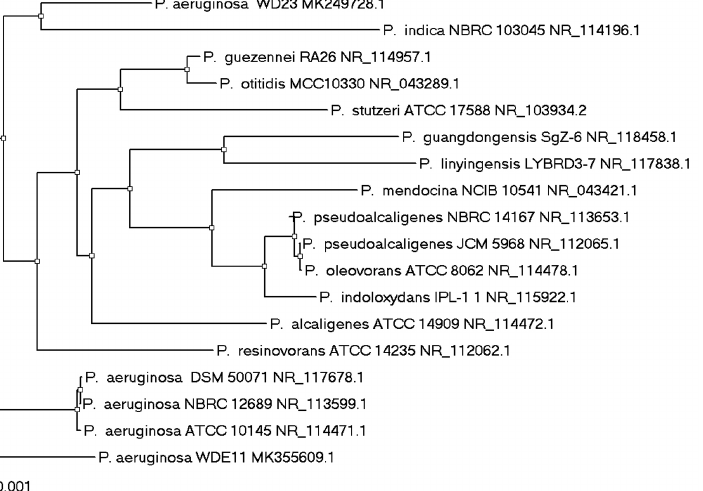
Fig. 4b. Phylogenetic tree showing the relationship of isolated WD23 and WDE11 with isolates showing homology as obtained from BLASTn